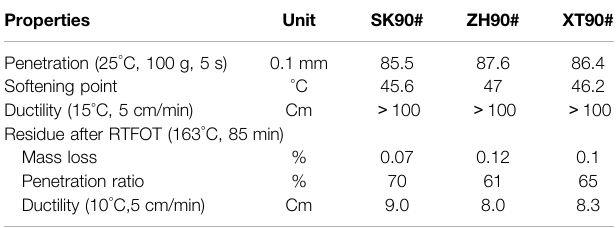
TABLE 1 | properties of virgin asphalt.